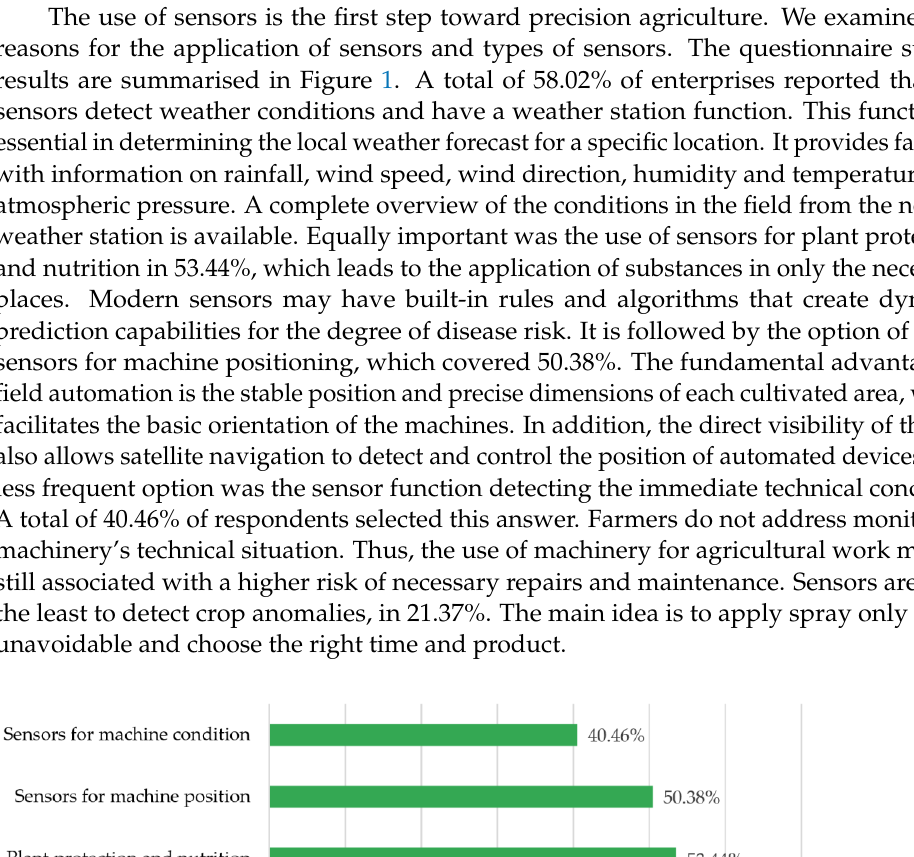
Table 1. Results of statistic evaluation for sensors in crop production.